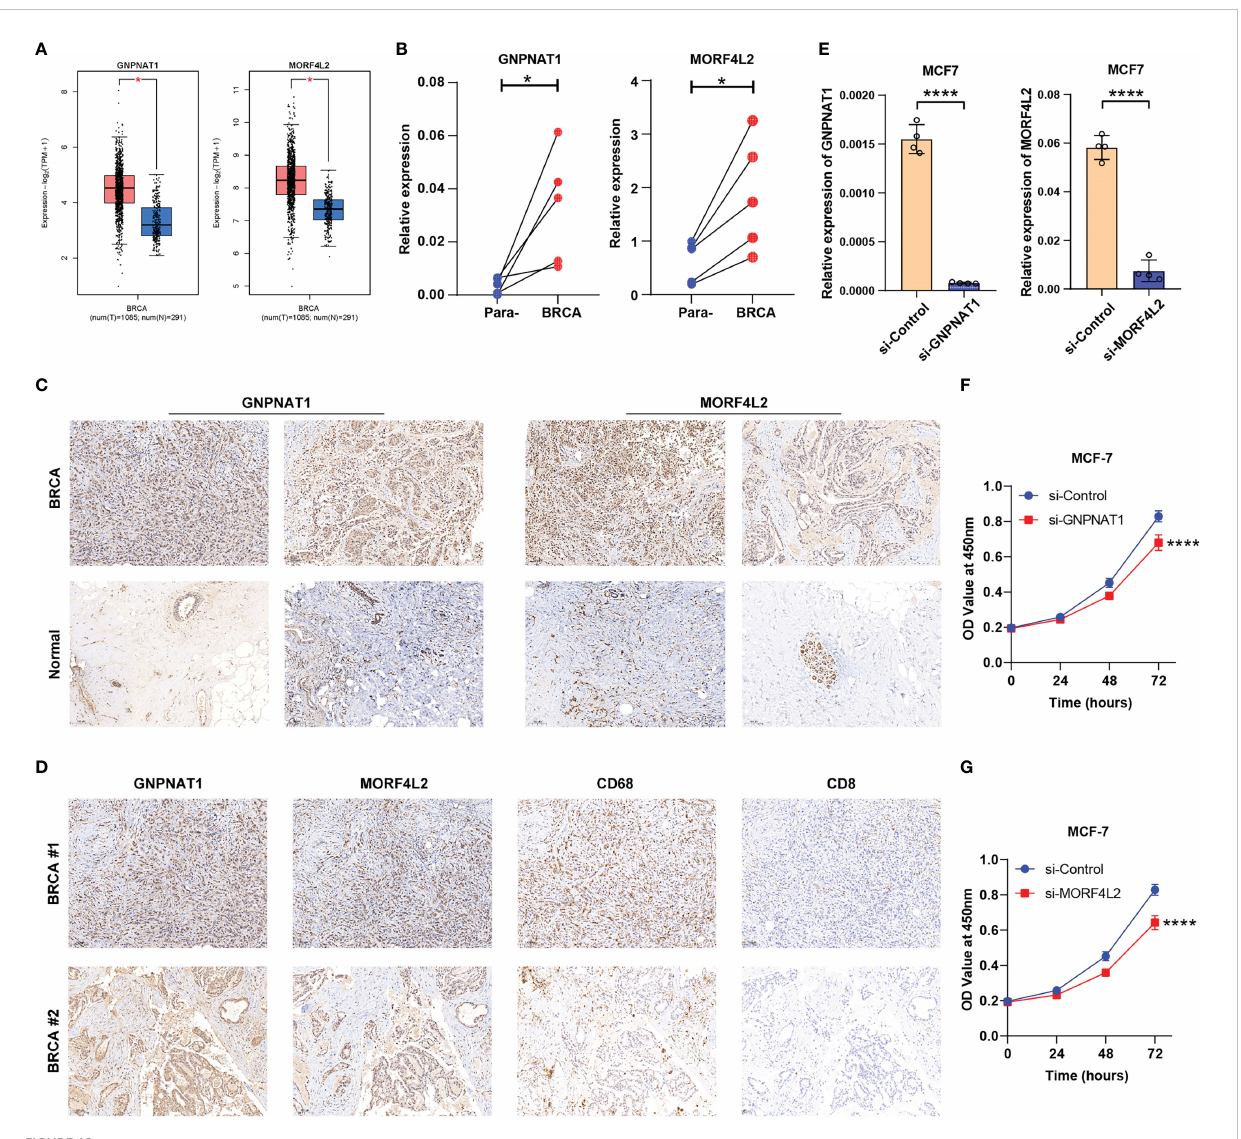
FIGURE 12 Expression validation and functional exploration of two key DRGs. (A) GEPIA database analyses demonstrated the differential expression of GNPNAT1 and MORF4L2 in BRCA and normal breast tissues. (B, C) RT-qPCR and IHC (10×) experiments showed the elevated expression of GNPNAT1 and MORF4L2 in BRCA tissues compared with adjacent normal tissues. (D) IHC assays (10×) revealed the association of key DRGs with macrophages and CD8 + T cells. (E) The expression of GNPNAT1 and MORF4L2 was knocked down in the targeted group. (F, G) Knockdown of either GNPNAT1 or MORF4L2 could suppress the proliferation activity of MCF-7 cells. (*P < 0.05, ****P <